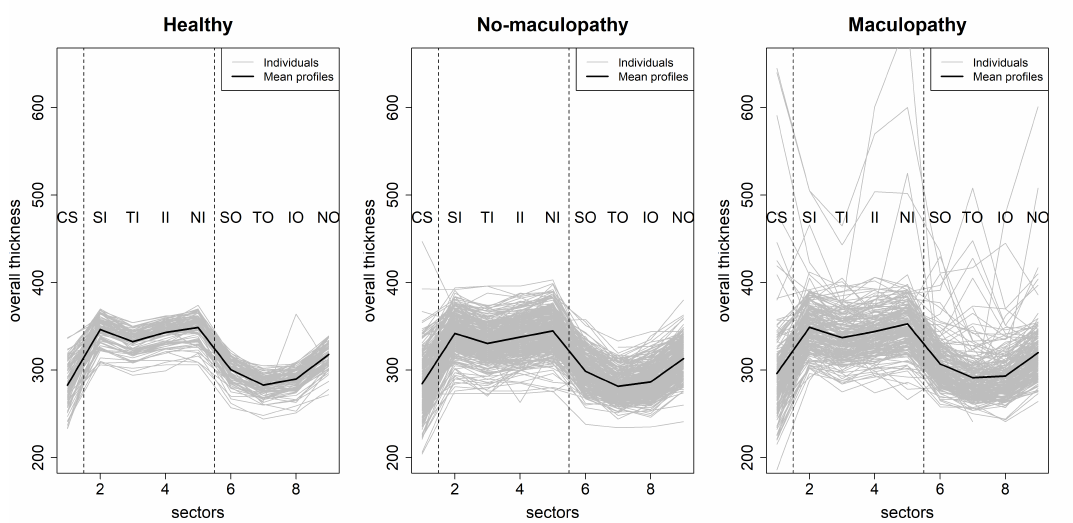
Figure 3. Visualizations of retinal overall thickness over nine sectors in the ETDRS grid for healthy group (the left panel), no-maculopathy group (the middle panel) and maculopathy group (the right panel). The grey lines represent profiles of all the individual eyes in this group, and the solid black lines represent the mean profiles for each group.